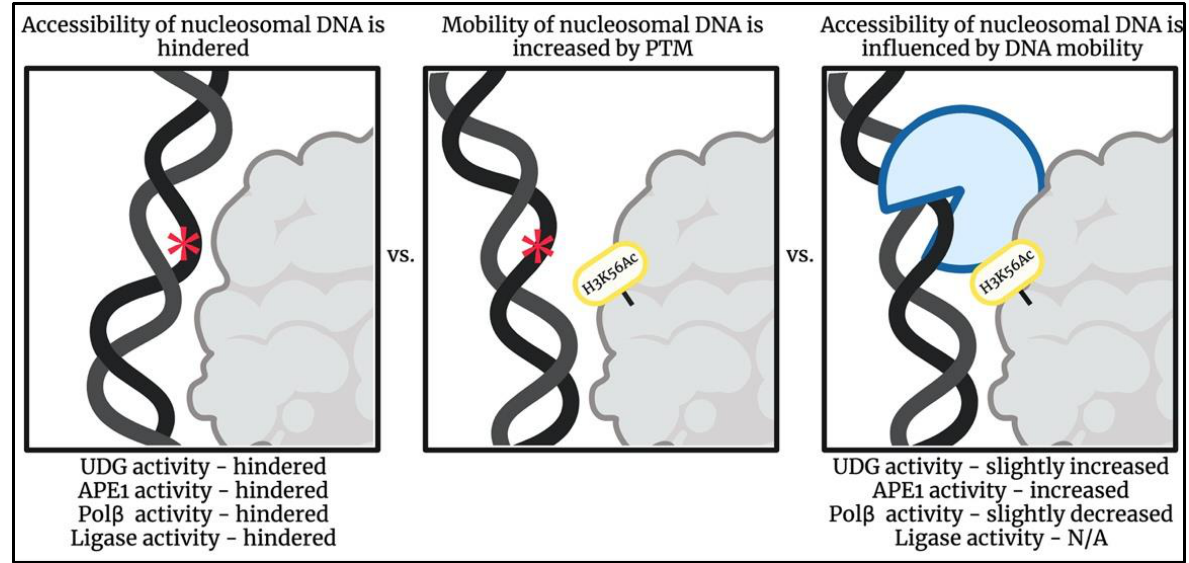
Figure 3. Schematic illustrating how a post-translational modification, H3K56Ac, can increase DNA mobility allowing for altered binding patterns of BER enzymes in regions otherwise hindered [117,118,121 – 131]. Impact of H3K56Ac on DNA ligase activity has not been reported. DNA lesion represented by red asterisk symbol. Image created using BioRender.